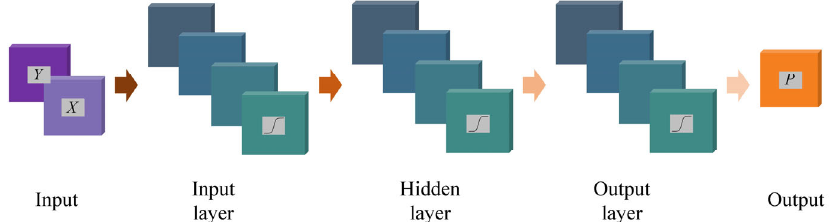
Fig. 1 Illustrative structure of a PINN with three